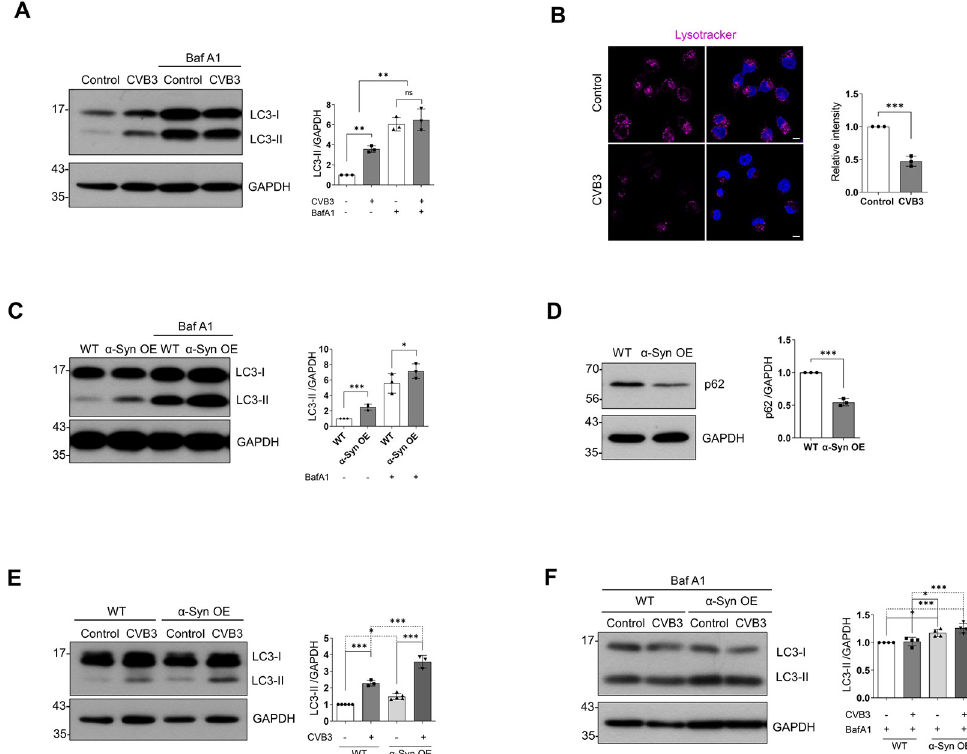
Fig 5. CVB3 and α -syn differentially regulate autophagic activity. (A) Samples of control and CVB3 infected (0.25 MOI for 24 h) dSH-SY5Y cells treated with dimethylsulfoxide (DMSO) or 50 nM bafilomycin A1 (BafA1) were lysed and western blotting was performed using LC3 antibody. Protein levels were quantified by densitometry. Values are derived from three independent experiments (n = 3). �� P < 0.01, one-way ANOVA test with Tukey’s multiple comparison test. (B) ICC images of dSH-SY5Y cells infected with CVB3 (MOI 0.25) for 24 h. Fluorescence was seen using LysoTracker. Values are derived from three independent experiments (n = 3). Scale bar indicates 10 μ m. ��� P < 0.001, unpaired t-test. (C) The relative expression level of p62 between WT and α -syn OE dSH-SY5Y cells. Protein levels were quantified by densitometry. Values are derived from three independent experiments (n = 3). ��� P < 0.001, unpaired t-test. (D) The relative expression level of LC3 between WT and α -syn OE dSH-SY5Y cells treated with DMSO or 50 nM BafA1 for 24 h. Protein levels were quantified by densitometry. Values are derived from three independent experiments (n = 3). ��� P < 0.001, � P < 0.05, one-way ANOVA test with Tukey’s multiple comparison test. (E and F) The relative expression levels of LC3 between WT (control and CVB3) and α -syn OE (control and CVB3) dSH-SY5Y cells with DMSO or 50 nM BafA1. Cells were infected with 0.25 MOI CVB3 for 24 h. Protein levels were quantified by densitometry. Values are derived from three independent experiments (n = 3). ��� P < 0.001, � P < 0.05, one-way ANOVA test with Tukey’s multiple comparison